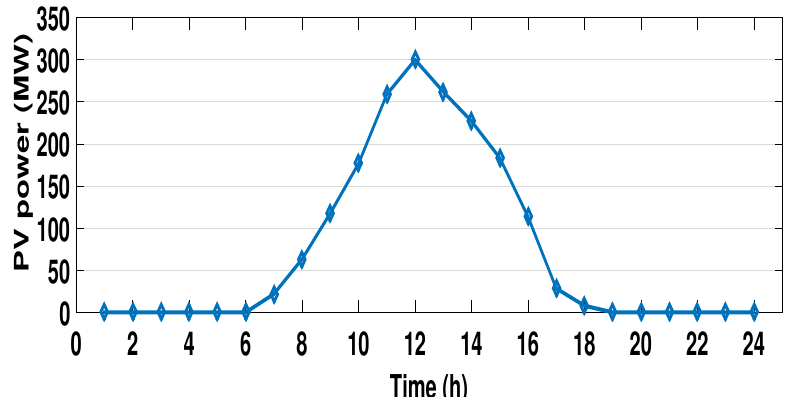
Figure 8. PV output